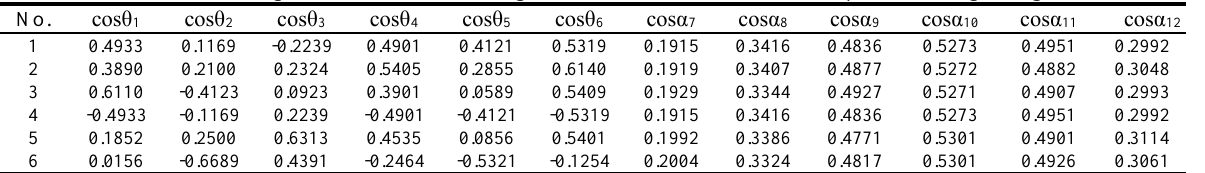
Table 3 The average direction cosine of change vectors and midline vectors in all possible change categories